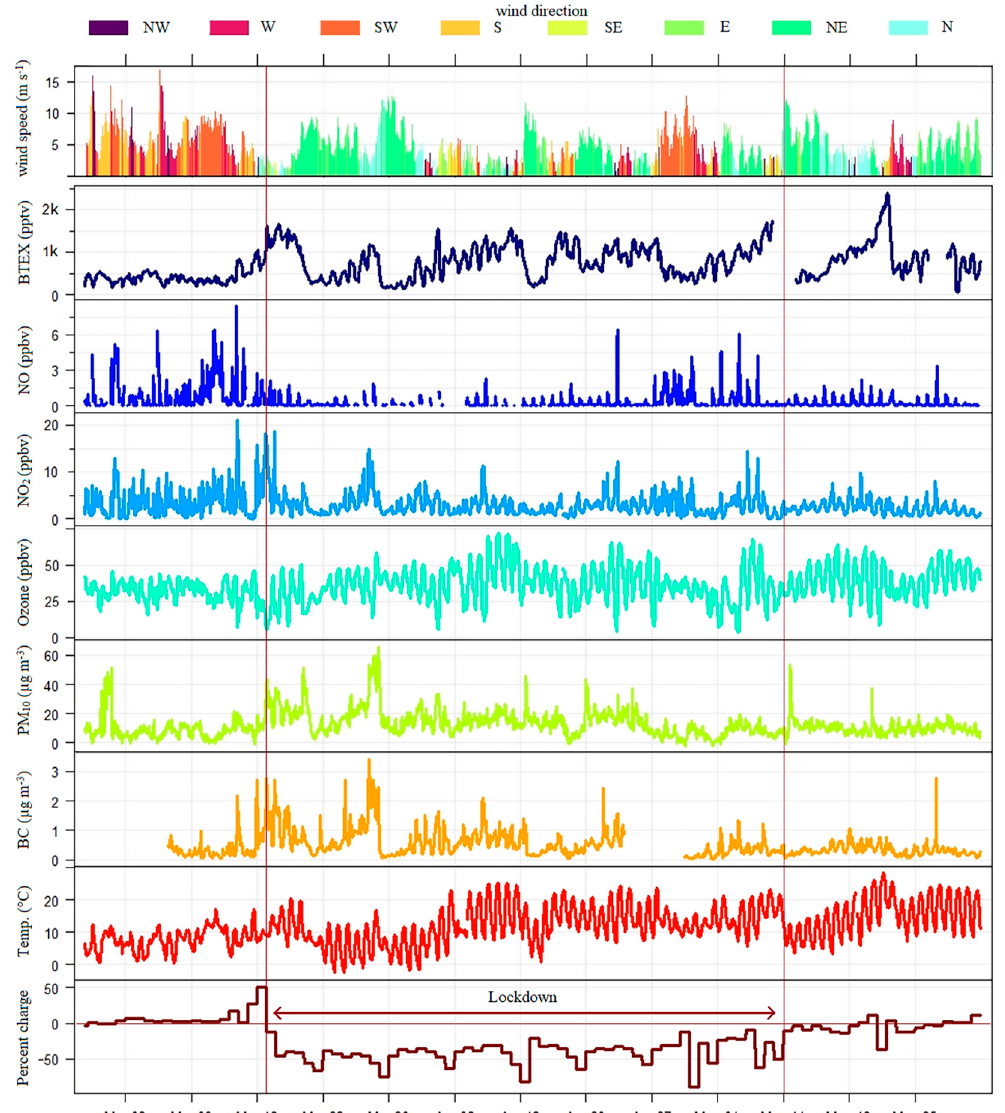
Figure 2. Time series of hourly BTEX (pptv, y axis of BTEX 1k = 1 × 10 3 ), NO (ppbv), NO 2 (ppbv), O 3 (ppbv), PM 10 (µg m –3 ), black carbon (µg m –3 ), and temperature (°C) in Orléans during the studied period, with daily “percent change in the grocery and pharmacy”, and meteorological parameters (wind speed in m s –1 , wind direction in a color-coded way).